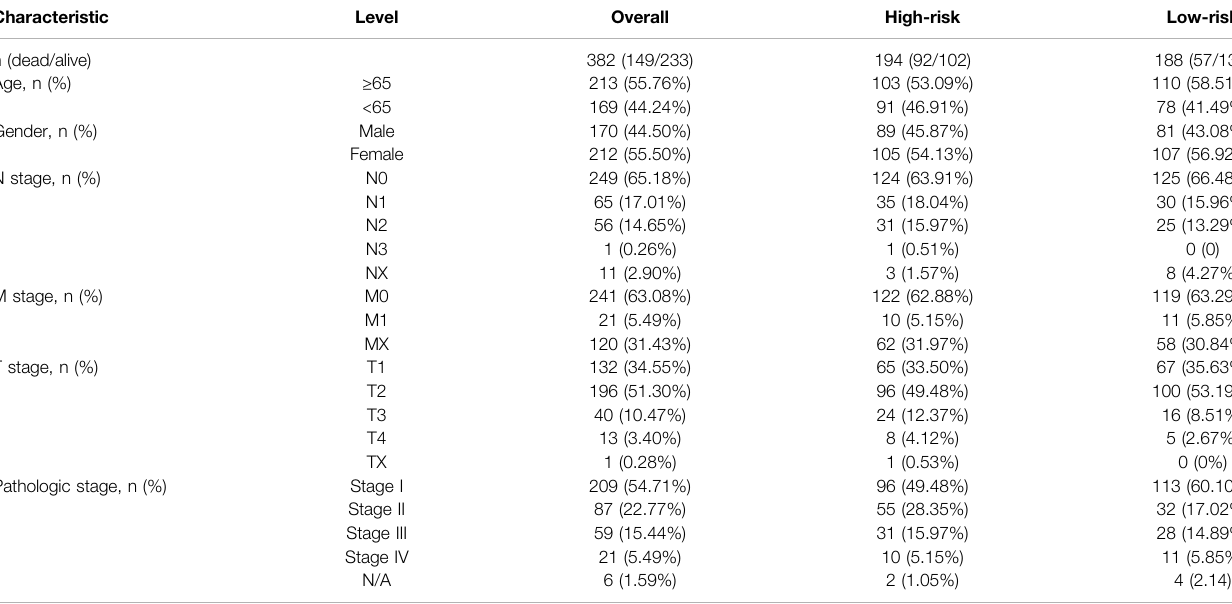
TABLE 1 | Clinical index of LUAD patients used in the Cox model.